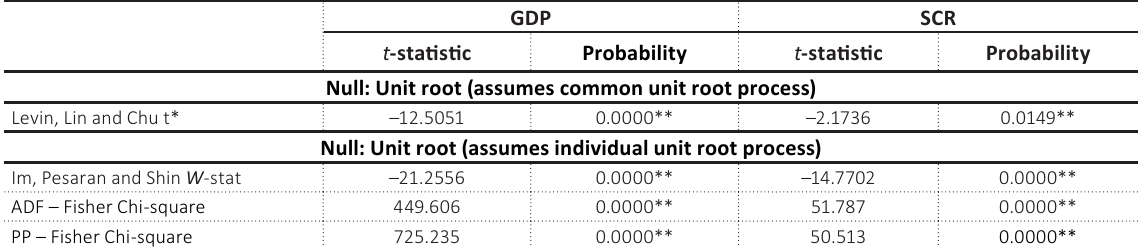
Table 1. Panel unit root test results